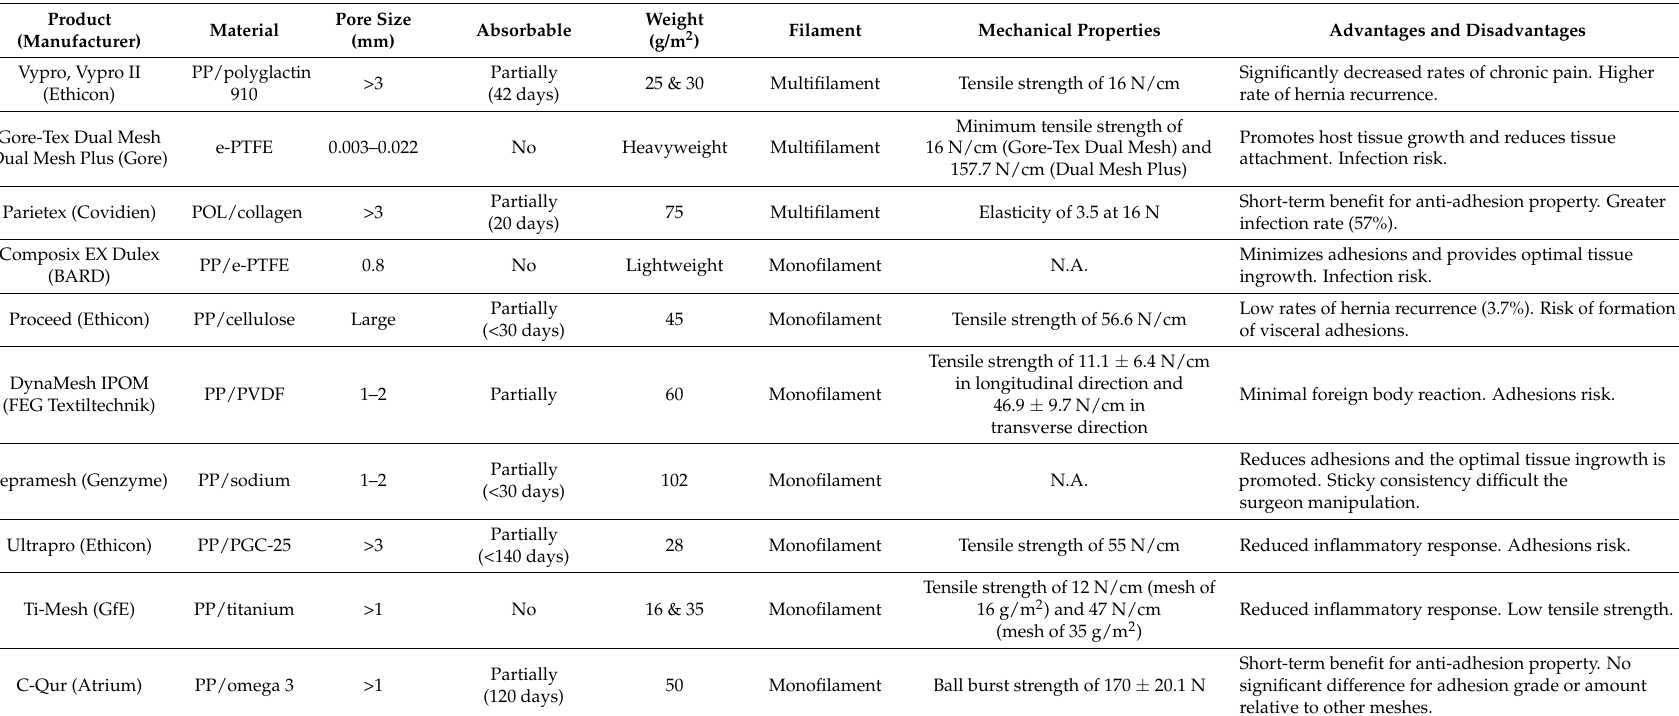
Table 2. Classification of commercially available second generation surgical meshes